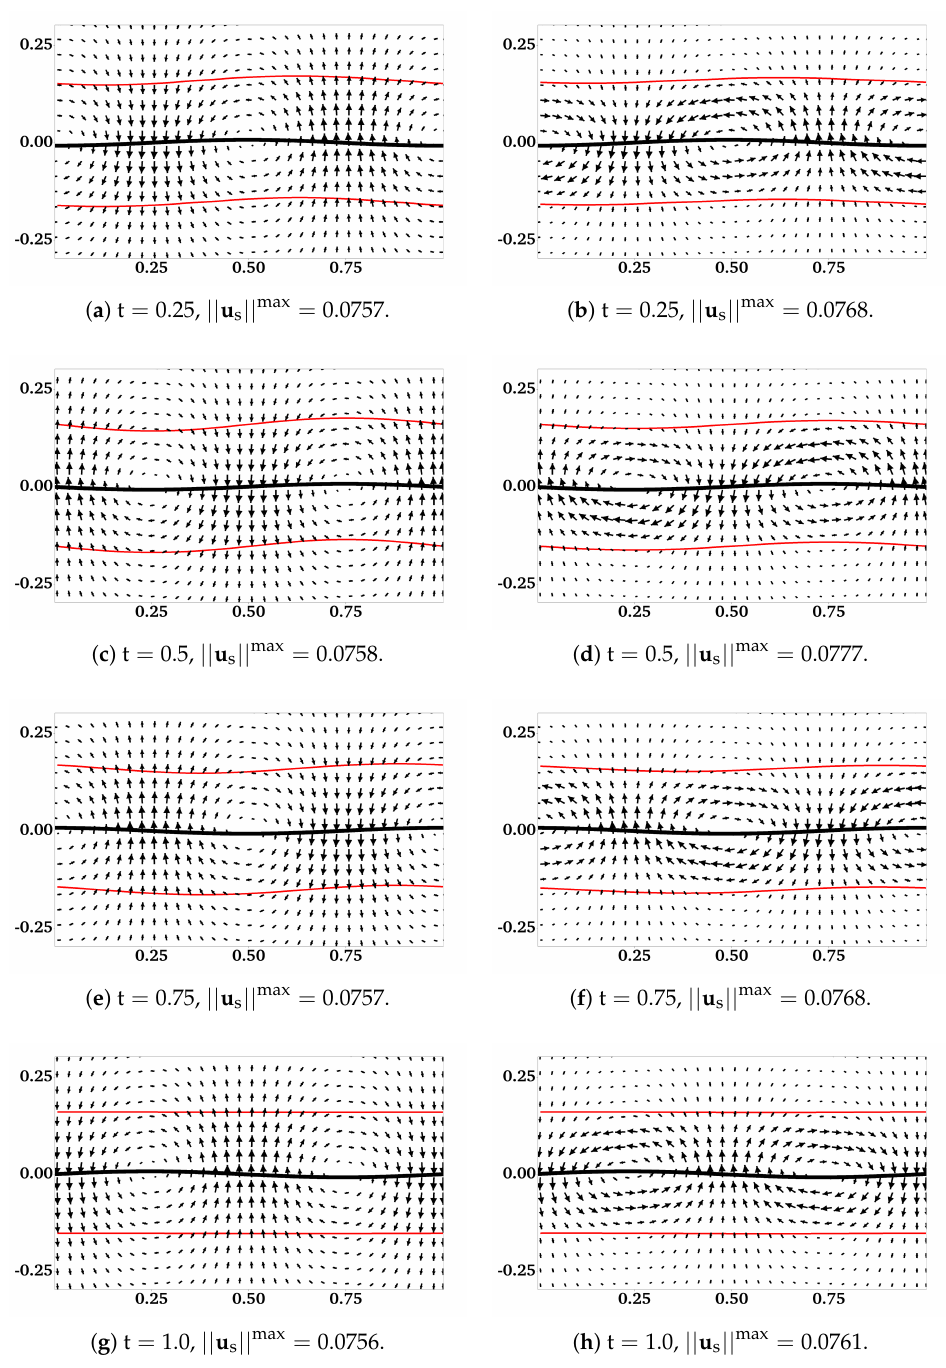
Figure 6. H = 0.16. Distributions of u s , the profiles of swimming sheet (black curves) and fluid interfaces (red curves) for different β . ( a , c , e , g ) are for β = 0.5. ( b , d , f , h ) are for β = 0.1. All vectors have the same